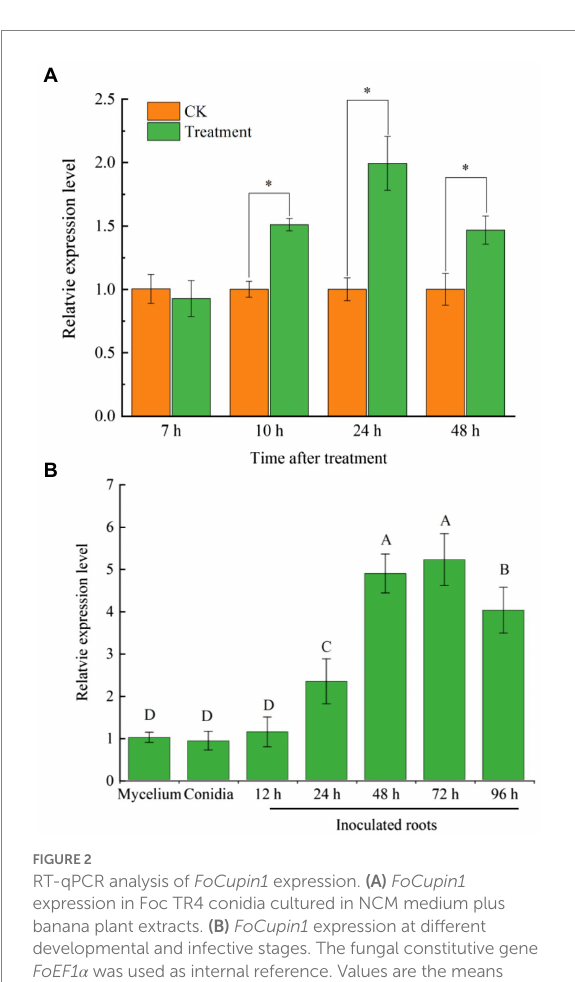
FIGURE 2 RT-qPCR analysis of FoCupin1 expression. (A) FoCupin1 expression in Foc TR4 conidia cultured in NCM medium plus banana plant extracts. (B) FoCupin1 expression at different developmental and infective stages. The fungal constitutive gene FoEF1 α was used as internal reference. Values are the means (±SE) based on three independent experiments and bars indicate standard deviations. Asterisks and different letters indicate statistical significance ( p < 0.05) using Student’s t